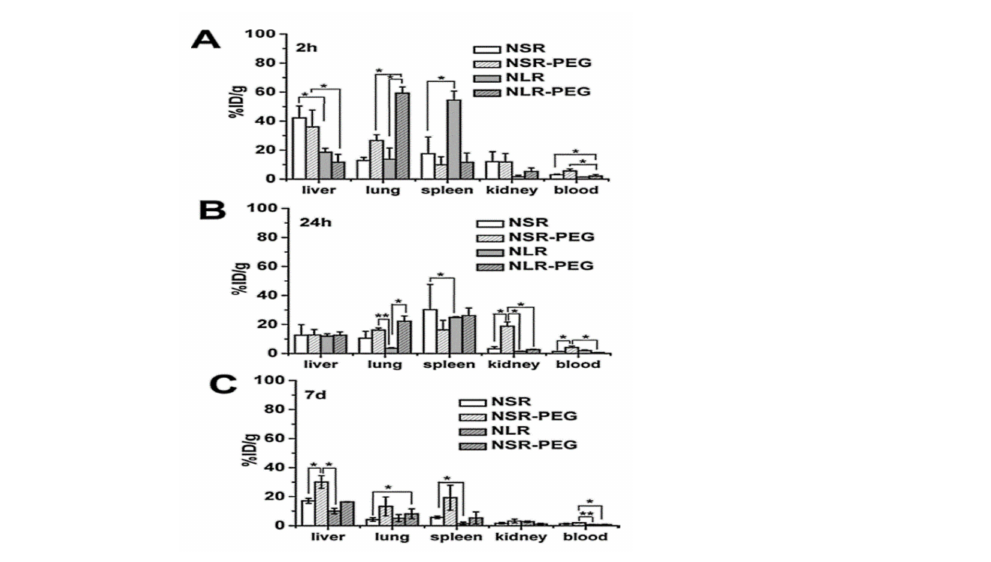
Figure 12. Quantitative analysis of differently shaped and PEGylated MSNs in organs and blood by ICPOES. Relative Si contents in liver, spleen, and kidney at ( A ) 2 h, ( B ) 24 h, and ( C ) 7 d post-injection. Data are the mean ± SD from three separate experiments. * p < 0.05; ** p < 0.01 for the comparison of Si contents of differently shaped and PEGylated MSNs in organs and blood. Reproduced with permission from [30], American Chemical Society, 2011. Table 3. The biocompatibility, biodistribution, and clearance of MSNs with different shapes, sizes, and surface modifications in vitro or in vivo (injection or oral